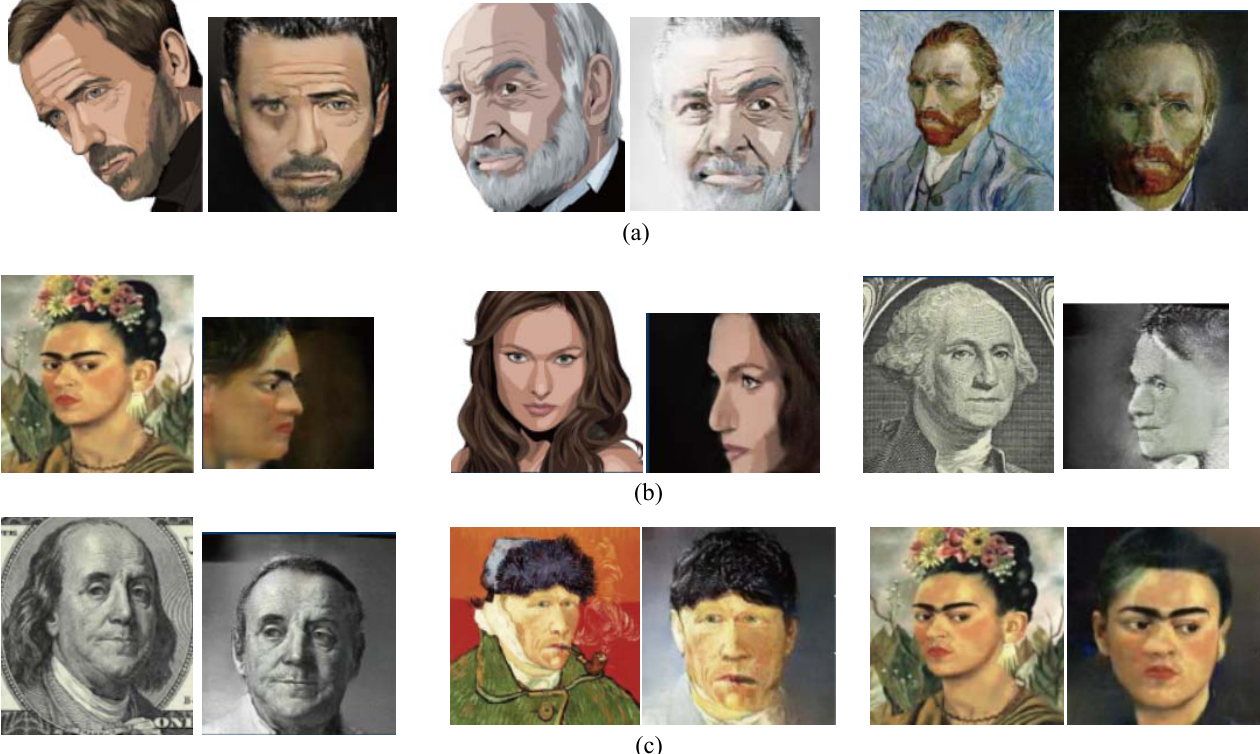
Figure 13. The limitations of our approach. ( a ) The input faces with highly rotated poses had problems after frontalization. ( b ) Rotating faces more than 60 ◦ produced poor results. ( c ) The attachments on the face were lost after rotation (Franklin lost his hair, Gogh lost his pipe, and Kahlo lost her